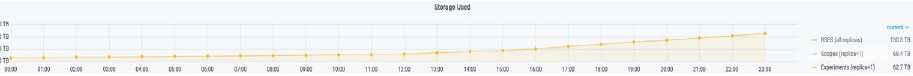
Figure 6: Used storage over time for experiments (FDR day)